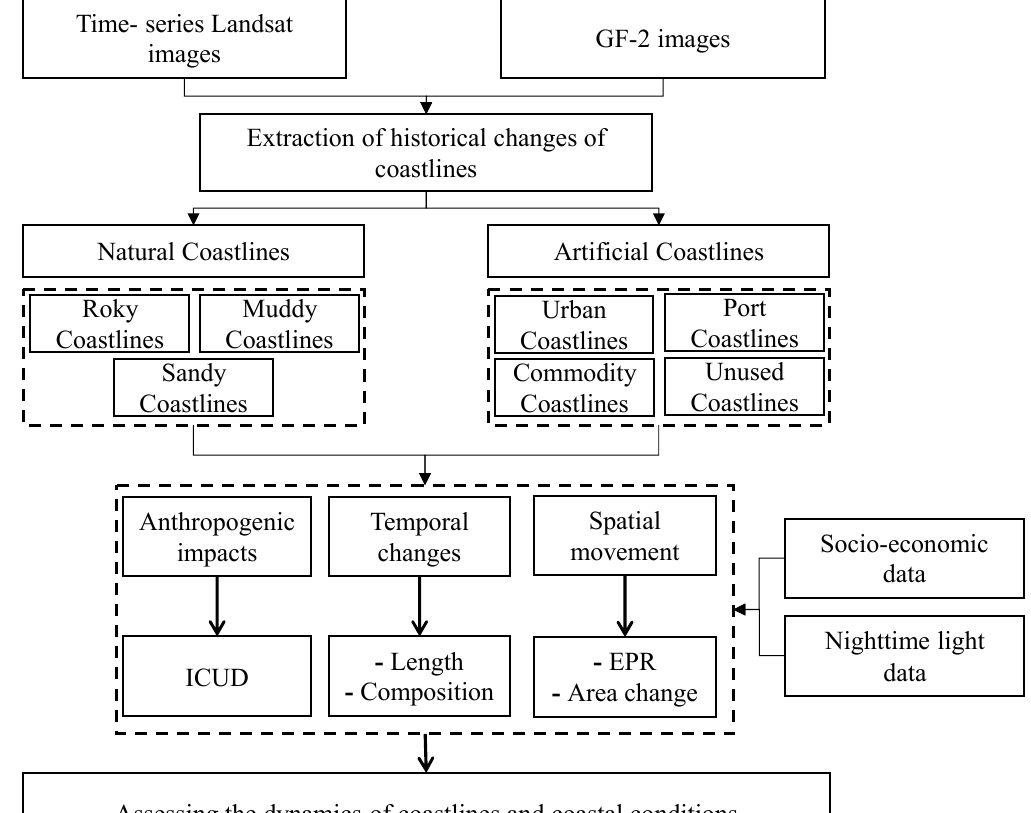
Figure 2. The framework to assess the dynamics of coastlines.